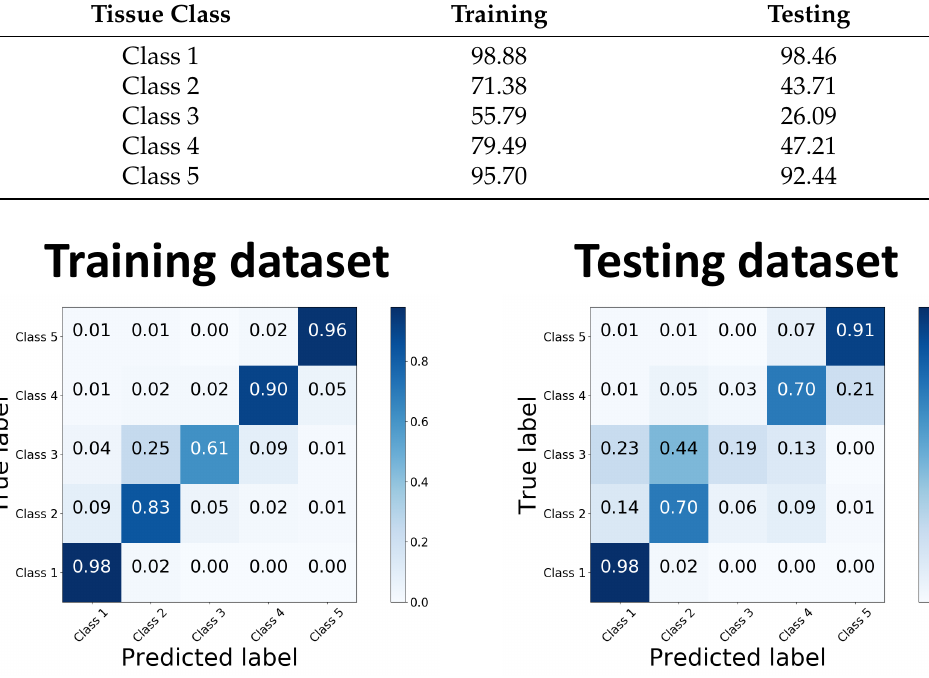
Figure 6. Comparison of confusion matrices calculated for training and testing